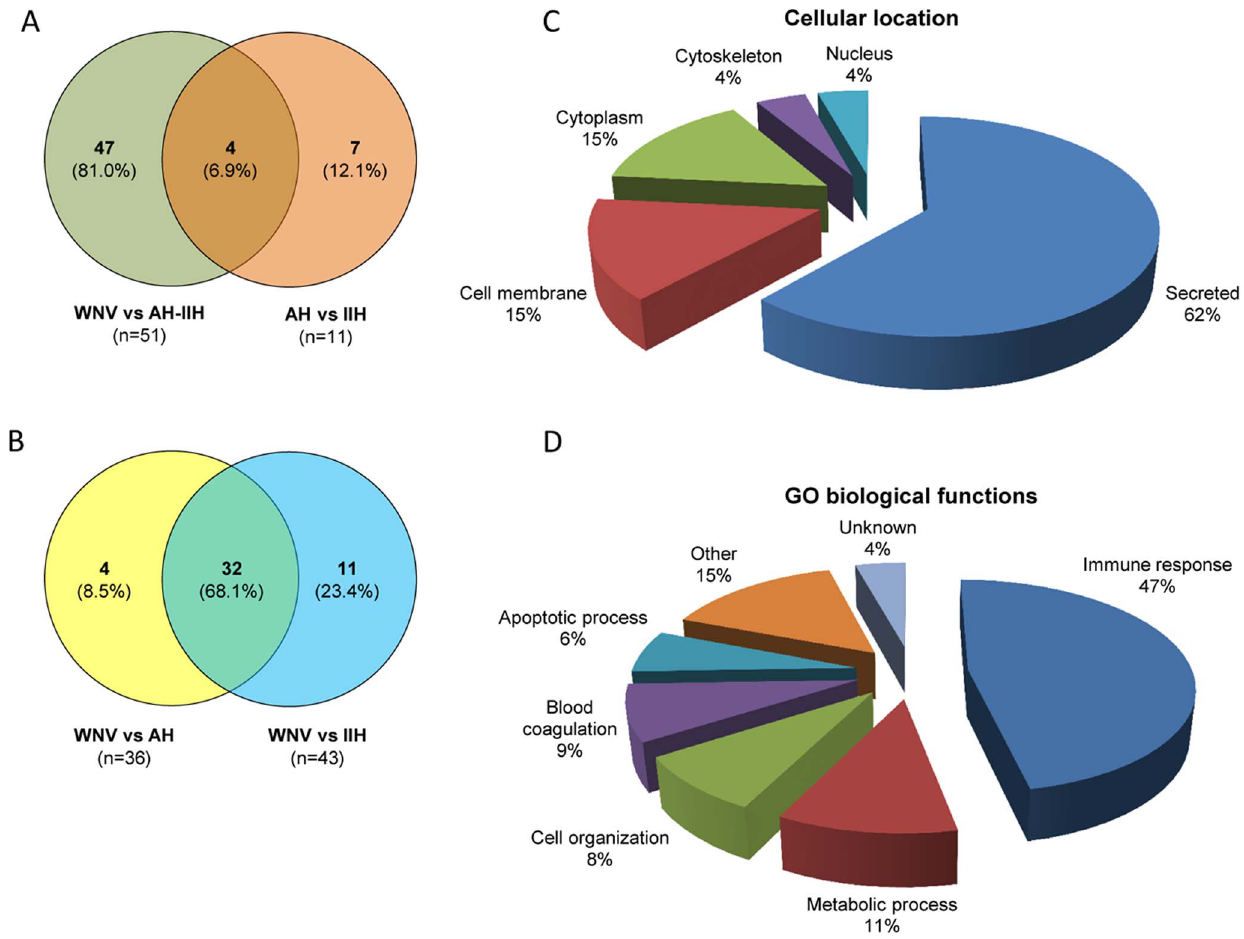
Figure 1. Classification of human CSF proteins significantly differentially expressed between WNND patients ( i.e. , A2 group) and control individuals ( i.e. , C2 and C3 groups) identified by quantitative LC-MS/MS analysis. (A) The number of proteins significantly differentially expressed between WNND group and AH + IIH control group or between AH and IIH control sub-groups are represented in the Venn diagram. (B) Venn diagram representation of proteins significantly differentially expressed between WNND group and AH or IIH control sub-groups, among the proteins found deregulated exclusively in patients with WNND compared to AH + IIH group (n=47). The two groups that were compared are indicated below each circle. The number and the percentage of proteins associated with each category are indicated in brackets. Classification of the significantly differentially regulated proteins according to their sub-cellular location (C) and their functional categorization (D) according to gene ontology (GO). The percentages of proteins associated with each category are indicated. WNND, West Nile neuroinvasive disease; AH, acute headache; IIH, idiopathic intracranial hypertension; CSF, cerebrospinal fluid.